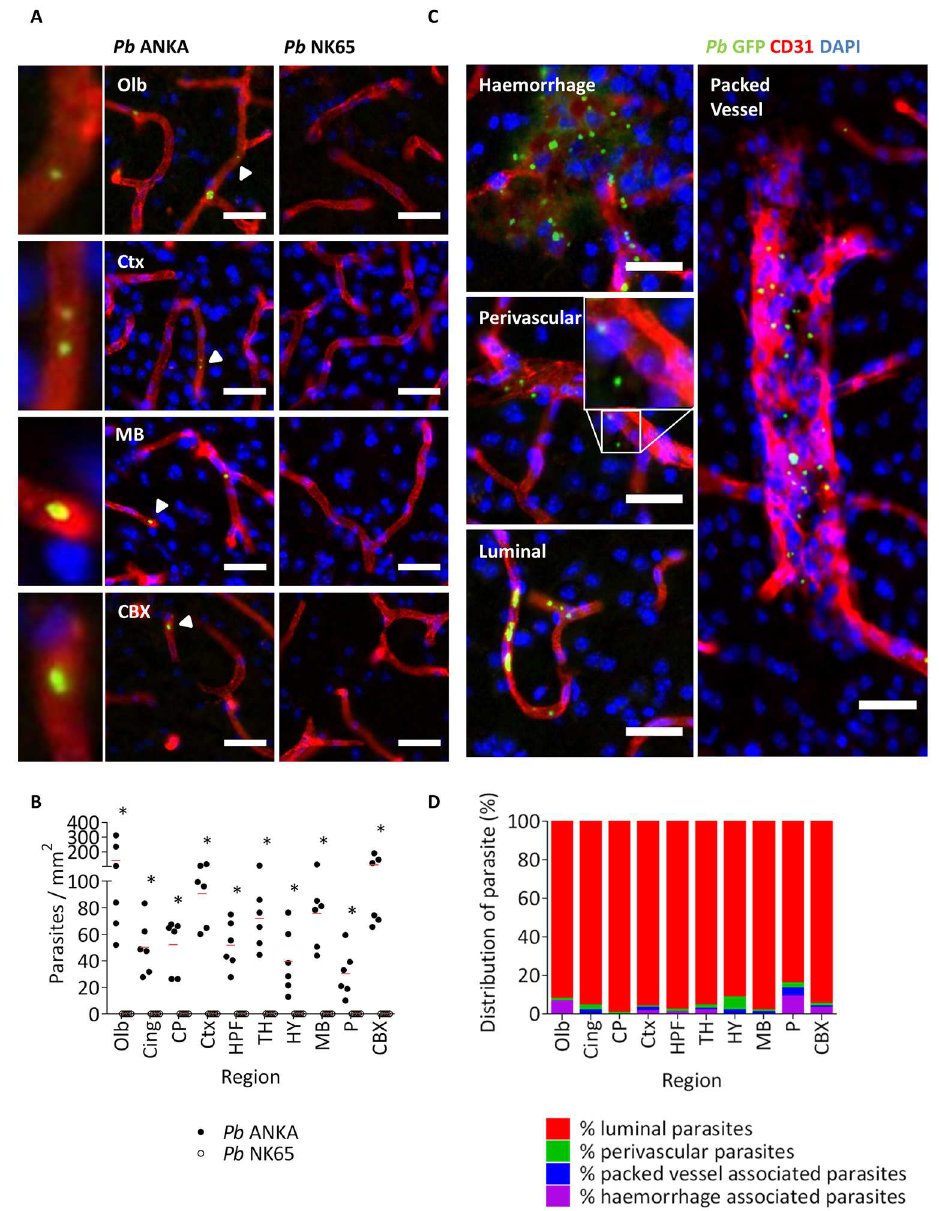
Fig 2. Intracerebral parasite accumulation occurs exclusively during ECM infection. C57BL/6mice were infected with 1x10 4 Pb ANKA GFP (n = 6) or 1x10 4 Pb NK65 GFP (n = 6) pRBCs. Mice were culled on d7 p.i. when Pb ANKA infected mice exhibitedsigns of late-stage ECM Brains were removed from transacardially perfusedmice and examinedvia immunofluorescencefor the presenceof GFP+ pRBCs (green)in relationto CD31+ vasculature(red), with nuclei counterstained blue. (A) Representative images demonstrate the presenceof GFP+ parasites ( Δ ) in the olfactory bulbs, cortex, midbrain and cerebellarcortex of Pb ANKA infected mice, and their respectiveabsencein Pb NK65 infected mice. Identified parasite is highlighted in digitallymagnifiedpanel adjacent (left). (B) Quantitation of GFP+ parasites within the different brain regions of Pb ANKA and Pb NK65 infected mice. (C) Representative images of the different types of cerebralparasite accumulation that occur duringECM. (D) The frequency (%) of GFP+ parasite observedto be: luminal; perivascular; haemorrhage-associated; or packed-vessel associated.Dots representmean of individual brains, with red lines mean of total brains. Bars represent mean frequencyfor all brains. Scale bar: 25 μ m. * p (cid:20) 0.05 (unpairedt-test, no assumptionmade for consistent